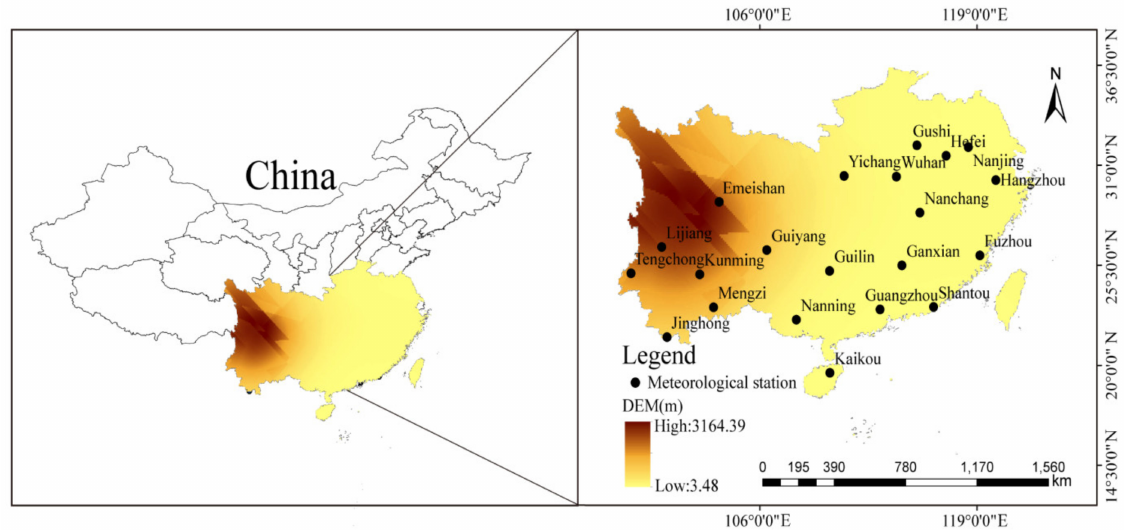
Figure 1. The geographical locations of the twenty-one weather stations in the humid areas of China in the present